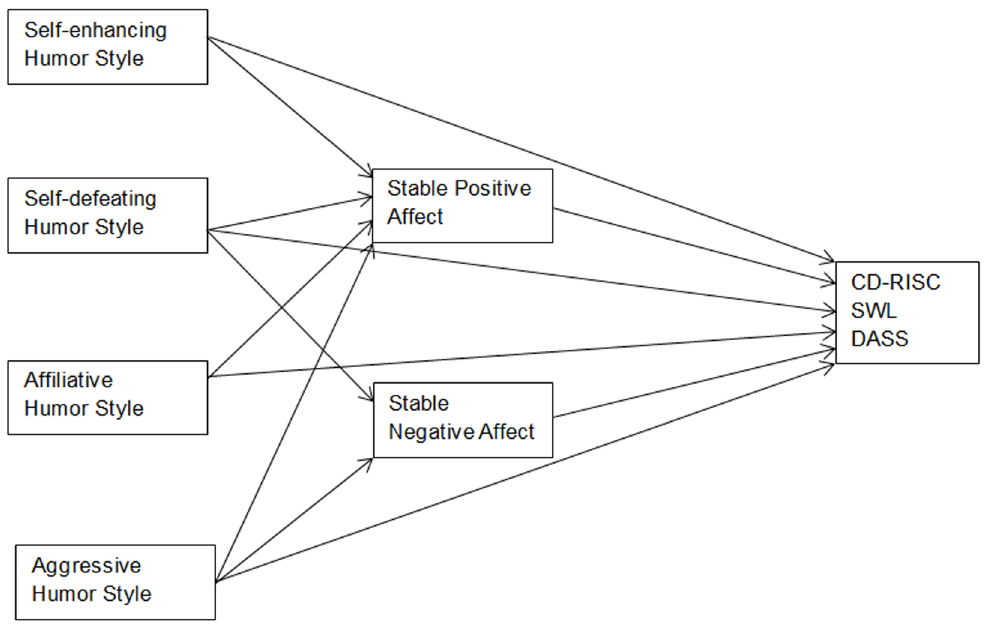
Figure 1. Direct and indirect paths tested for three outcome variables: Resilience (CD-RISC), Well-being (SWL), and Psychological Distress